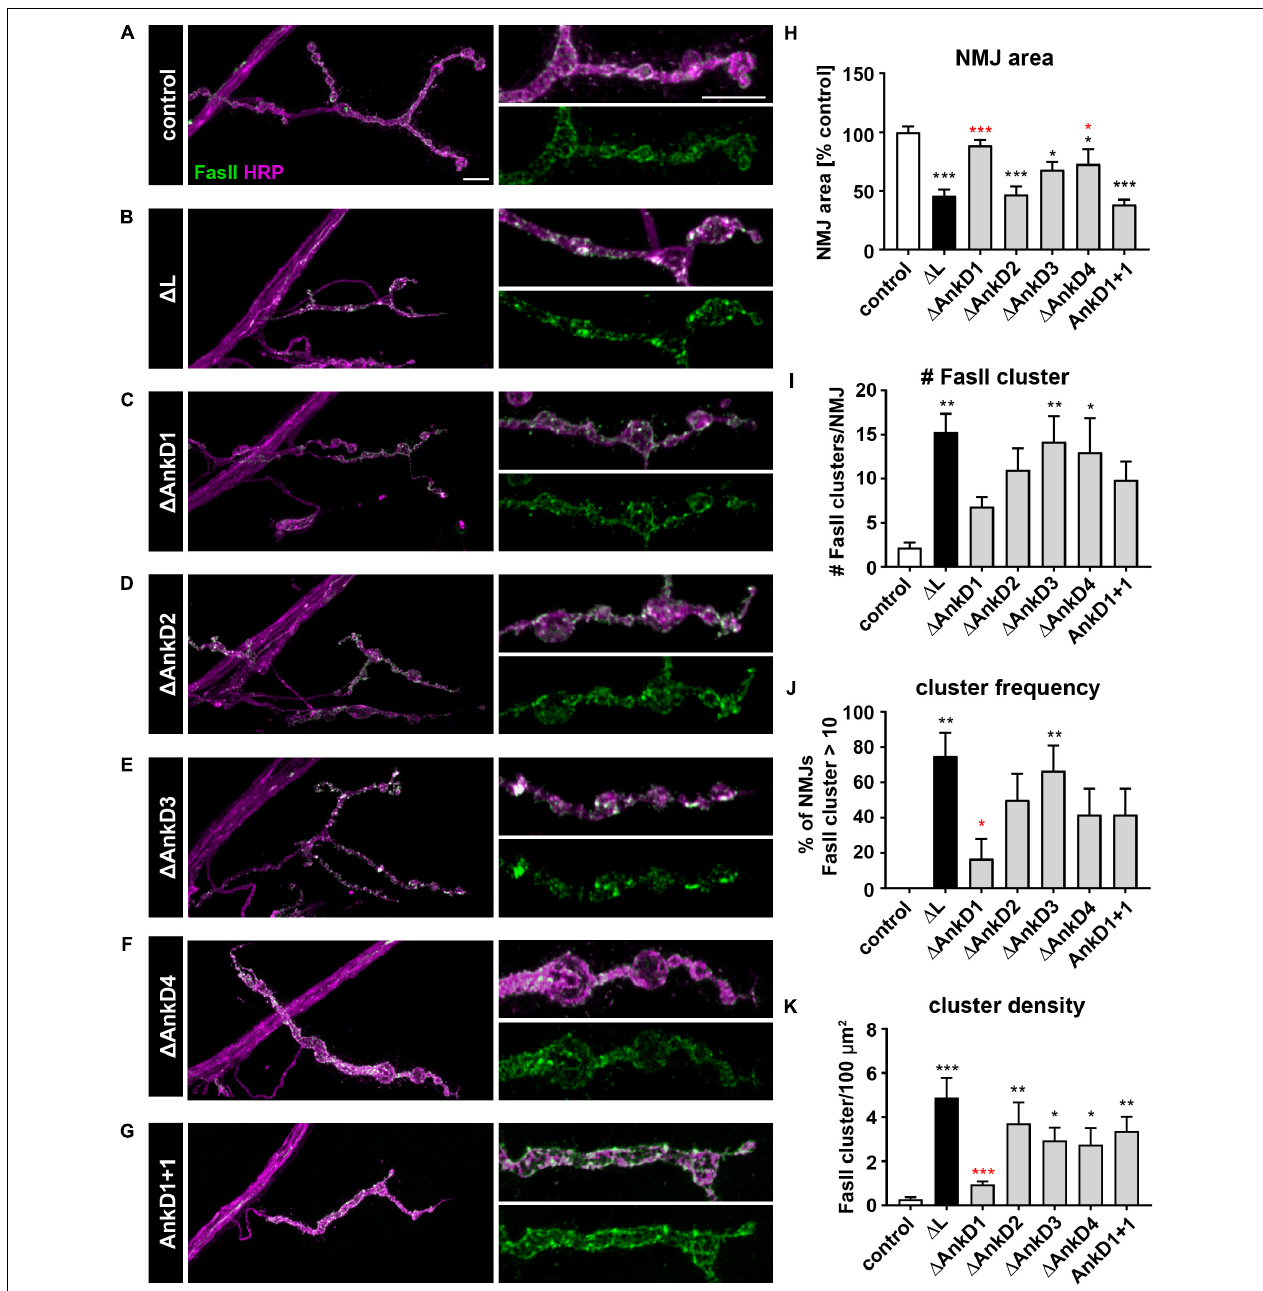
FIGURE 6 | Analysis of ARD-dependent control of synaptic CAM organization. (A–G) Analysis of the synaptic distribution of the CAM Fas II (green) at type Ib muscle 4 NMJs marked by HRP (magenta). In contrast to control animals ( P[ank2_wt] /+; ank2 (cid:49) L /ank2 null ) (A) absence of Ank2-L (B) or deletions/manipulations of the AnkDs (C–G) result in severe perturbations of the organization of the peri-active zone associated NCAM homolog Fas II. (H–K) Quantification of NMJ area (H) , number of Fas II cluster per NMJ (I) , frequency of NMJs displaying more than 10 Fas II cluster (J) and Fas II cluster density per 100 µ m 2 (K) ( n = 12 muscle 4 NMJs, three animals). Scale bars in (A) apply to (A–G) and represent 10 µ m. Error bars indicate SEM; ∗ p < 0.05, ∗∗ p < 0.01, ∗∗∗ p < 0.001 (ANOVA); black asterisks represent comparisons to controls; red asterisks represent comparisons to ank2 (cid:49) L